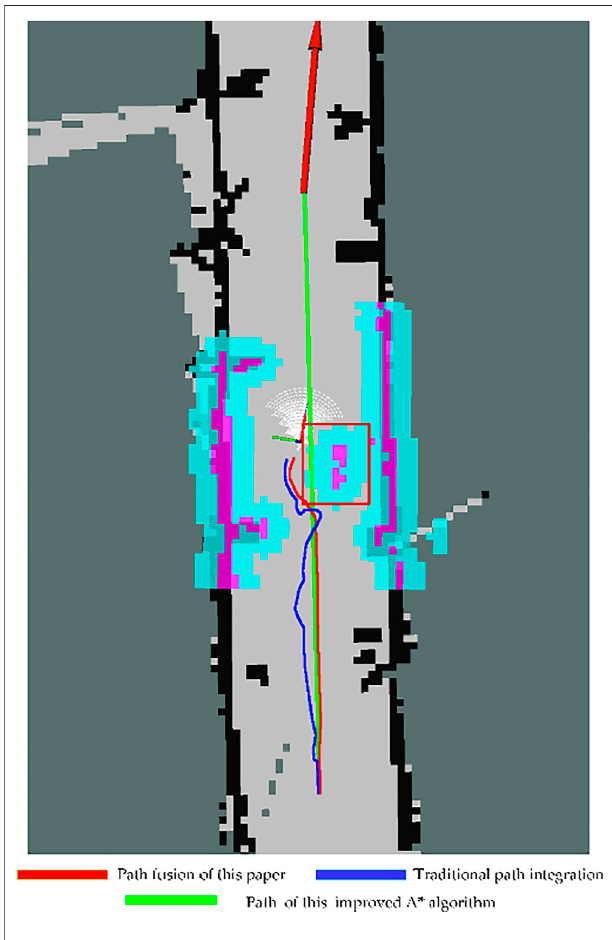
FIGURE 9 | Environmental mapping and path planning of the cable trench.